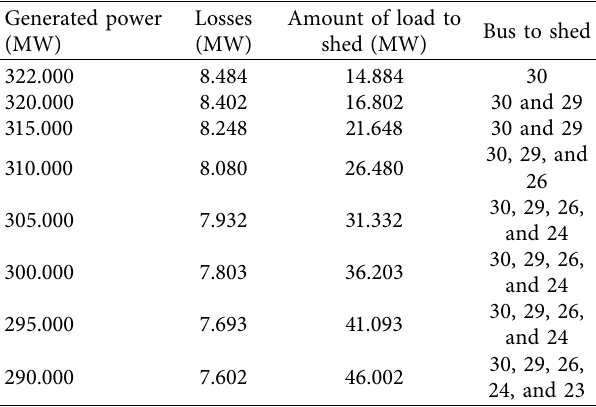
Figure 7: Losses versus generated power. Table 2: Load to be shed under different generation contingencies.